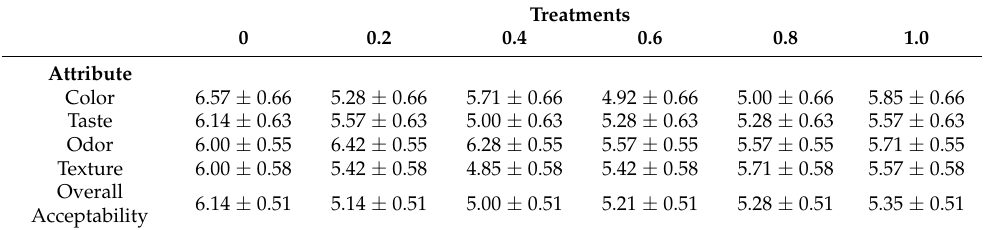
Table 2. Sensory attributes of intact chicken breast meat and restructured chicken breast meat